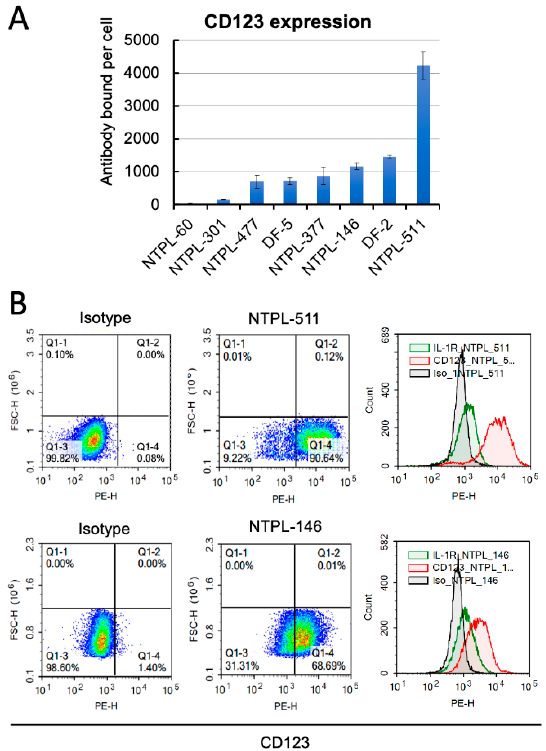
Figure 1. CD123 expression in pediatric AML PDX lines . ( A ) Graph shows the estimation of the number of antibody molecules bound per cell using Quantibrite fluorescence quantitation kit (BD Biosciences). Error bars denote SD of the mean from two independent experiments. ( B ) Flow cytometry plots showing PDX lines stained with PE-conjugated CD123 antibody or isotype control antibody.